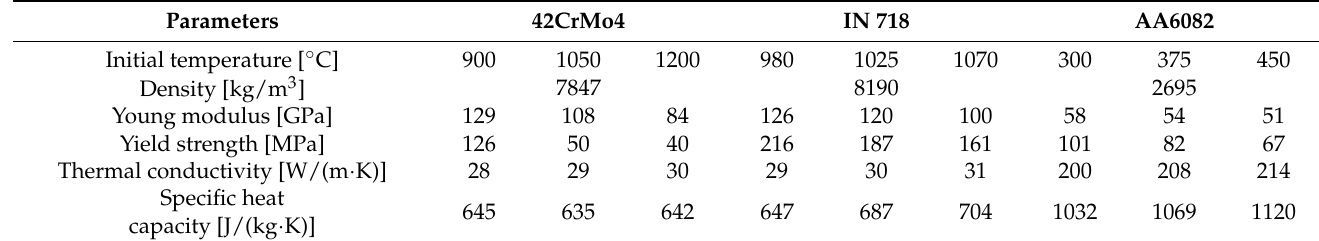
Table 4. Ring rolling mill characteristics and general process